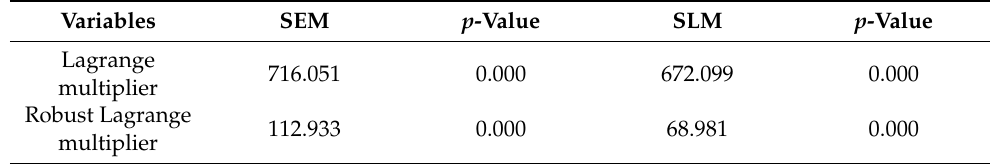
Table 4. LM test.